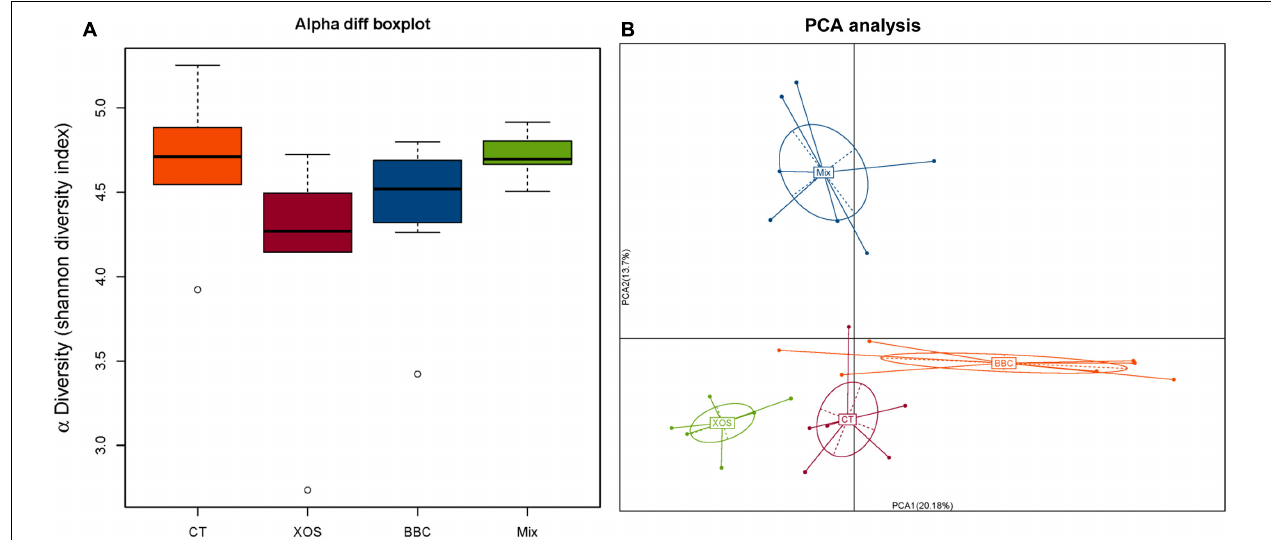
FIGURE 1 | The α diversity (A) and Principal Component Analysis (PCA) (B) of cecal microbiota among four groups. CT group, control group with basal diet; XOS group, basal diet plus 0.15% XOS; BBC group, basal diet plus 10 9 cfu/kg P. acidilactici BCC-1; MIX group, basal diet plus 0.15% XOS and 10 9 cfu/kg P. acidilactici BCC-1.